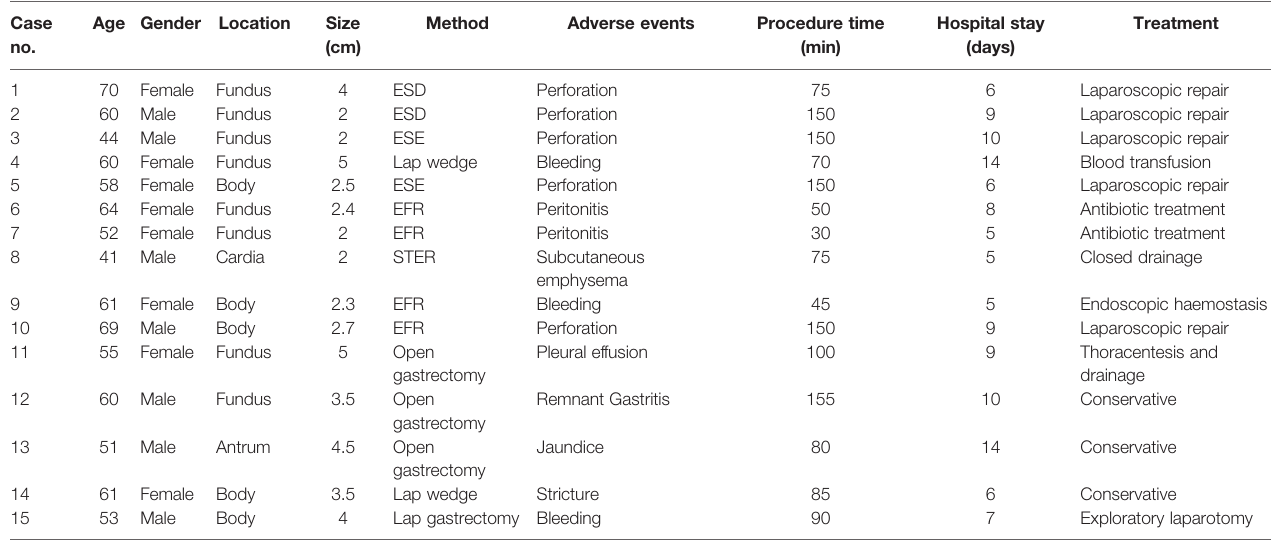
TABLE 5 | Clinical characteristics and treatments of patients with adverse events. Case no.